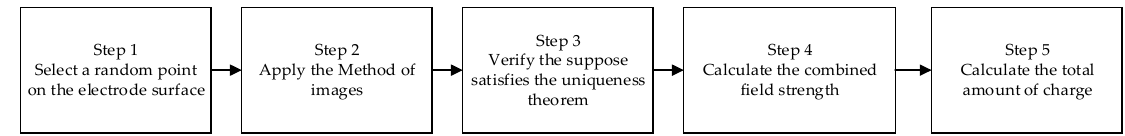
Figure 2. Steps of the proposed method to model the induced charge on a rode electrode.